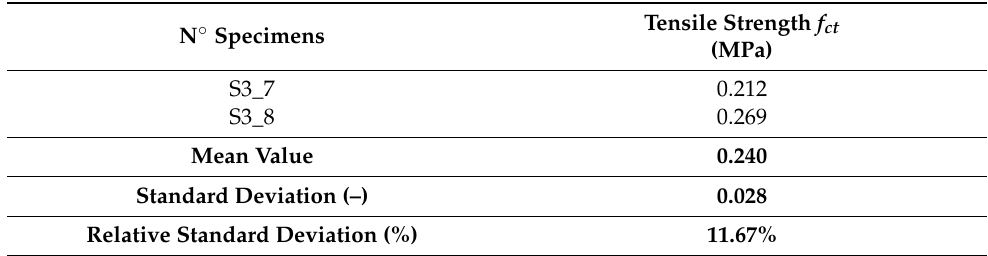
Table 5. Indirect tensile strength values of S3 specimens.